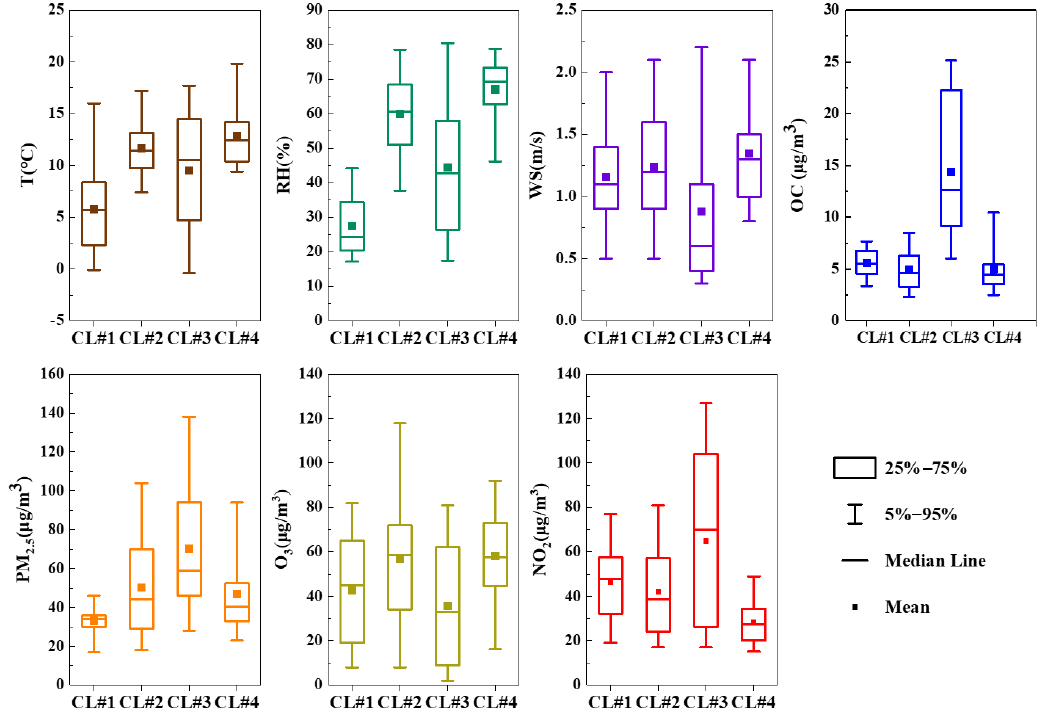
Figure 7. Box plots of meteorological parameters and pollutant concentrations in each cluster (squares and solid lines correspond to the mean and median, respectively; boxes indicate the 25th and 75th percentiles, and whiskers are the 5th and 95th percentiles).